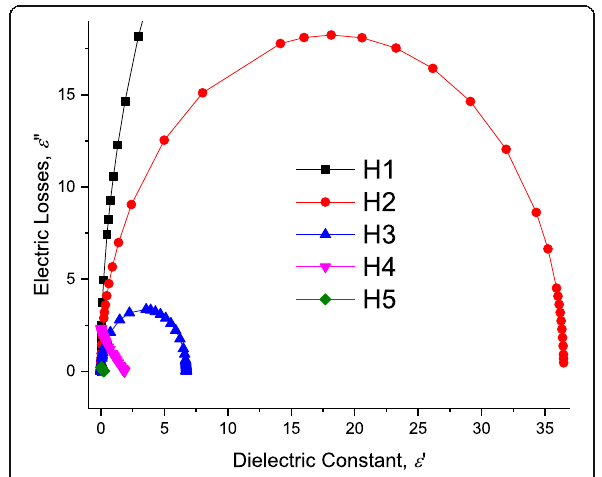
Fig. 22 Cole-Cole graph: dependence of electric losses as a function of dielectric constant at temperature = 298 K. One notices that H1, H2, H3, H4, and H5 have different behaviors